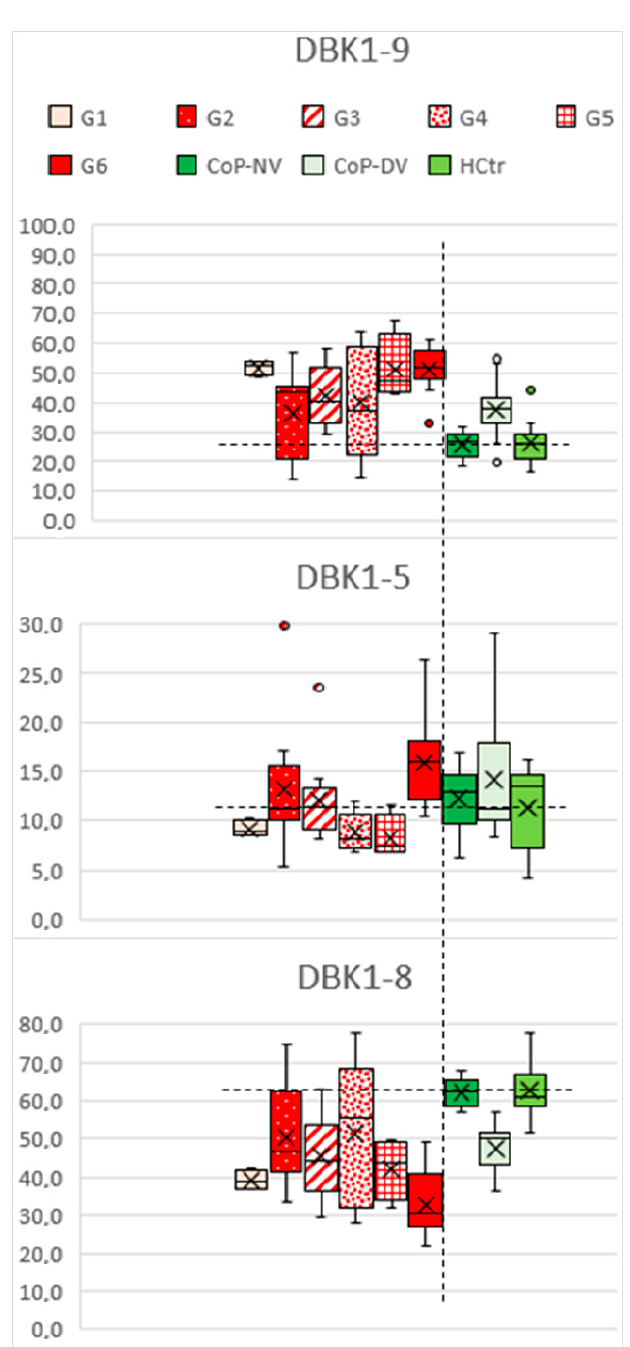
Figure 8, t -test results for significant differences in Figure 5B and a visual protein/group matrix in comparison to DBK results in Figure 5C).